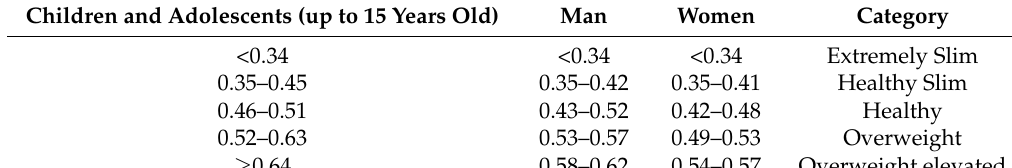
Table 3. Waist-to-Height Ratio classification using waist circumference and waist-hip ratio [32]. Children and Adolescents (up to 15 Years Old)